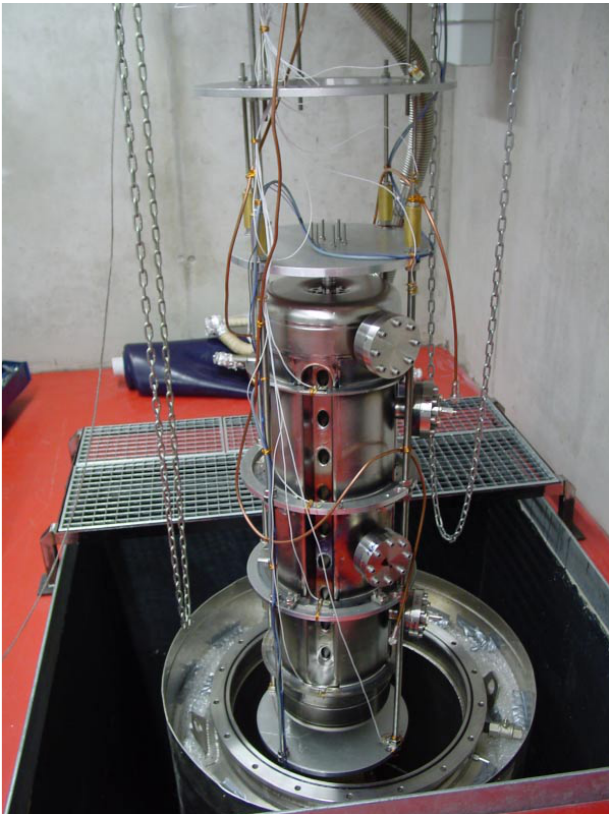
FIG. 27. (Color) Experimental setup for the first cryotest of the CH